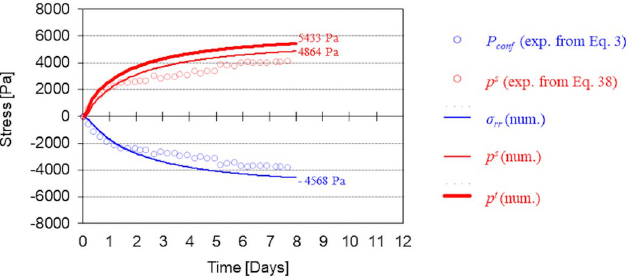
Fig 10. Comparison between numerical stress/pressures and the ones retrieved from the experimental results of CCT0. Blue circles are the confinement pressure obtained experimentally by inverse analysis with Eq 3; red circles is the solid pressure, p s , obtained from the measured displacement using Eq 39; solid lines are σ numerically.